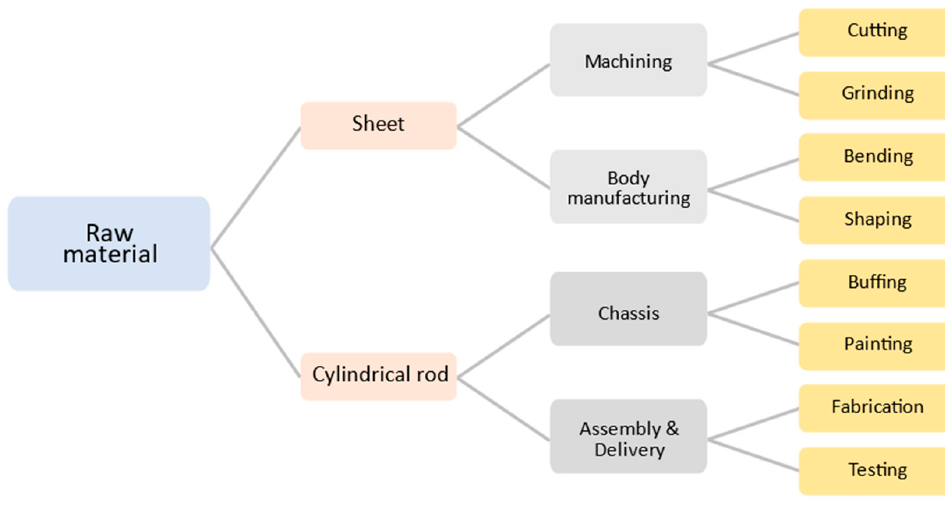
Figure 6. Process flow chart of the present shop floor.